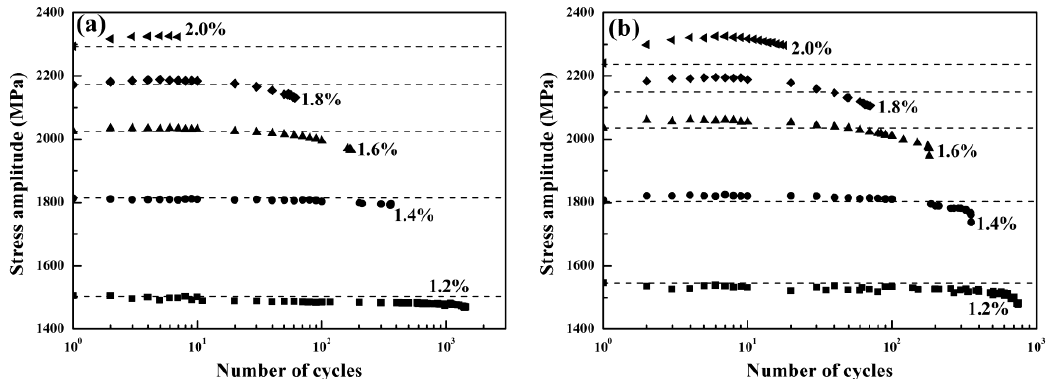
Figure 5. Stress amplitude vs. the number of cycles of the alloy under different aging conditions: ( a ) NA; and ( b ) DA.